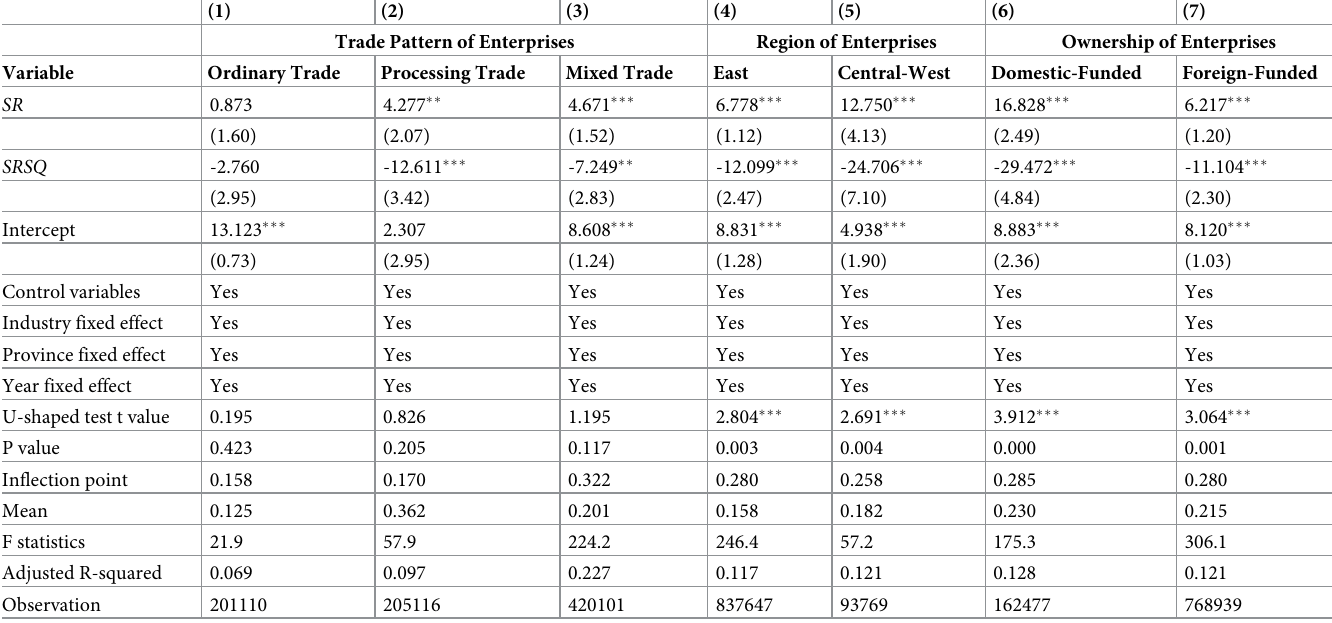
Table 5. The results of heterogeneity in enterprises